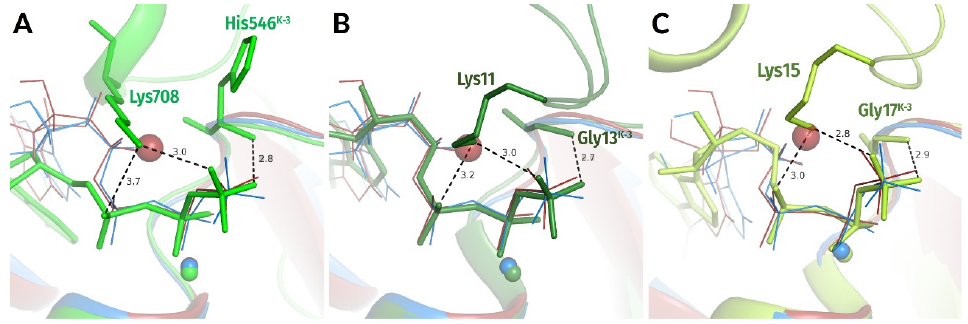
Figure 4. Conformation of native ATP molecules in selected crystal structures compared to MD simulations of the MnmE GTPase. Crystal structures of P-loop ATPases in complex with ATP molecules are shown in lime or green colors; they are superposed with conformations of GTP bound to the MnmE GTPase, as sampled from MD simulations of inactive monomer (blue) and active, K + -bound dimer (red); see also Figure S2 and [70]. All distances are given in